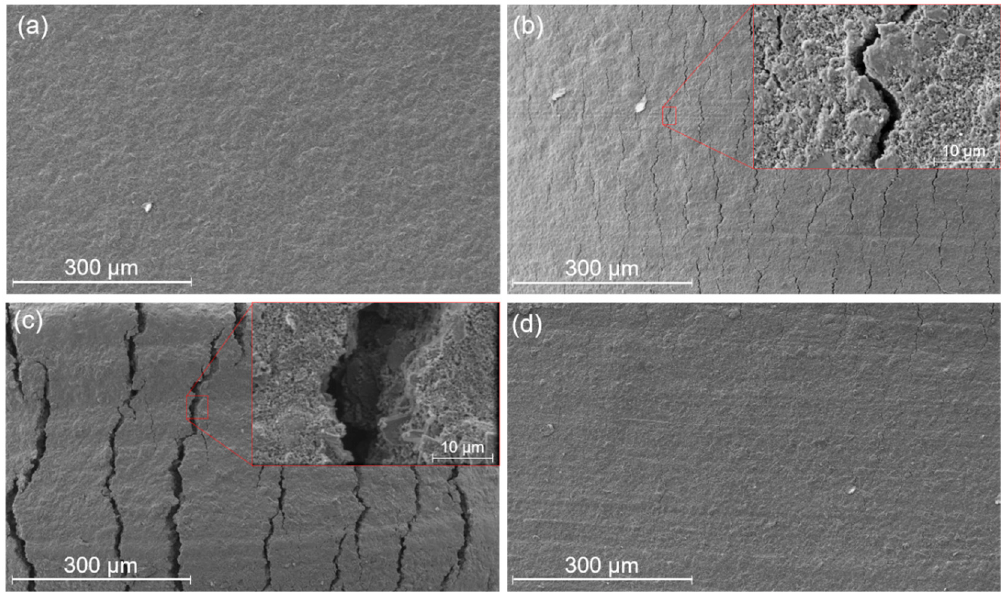
Figure 4. SEM images of the surface of solidified carbon ink layer on the PI substrate showing ( a ) initial state, ( b ) cracks at bending of 45 °, ( c ) cracks at bending of 90 °, and ( d ) restoring of cracks. state, ( b ) cracks at bending of 45 ◦ , ( c ) cracks at bending of 90 ◦ , and ( d ) restoring of